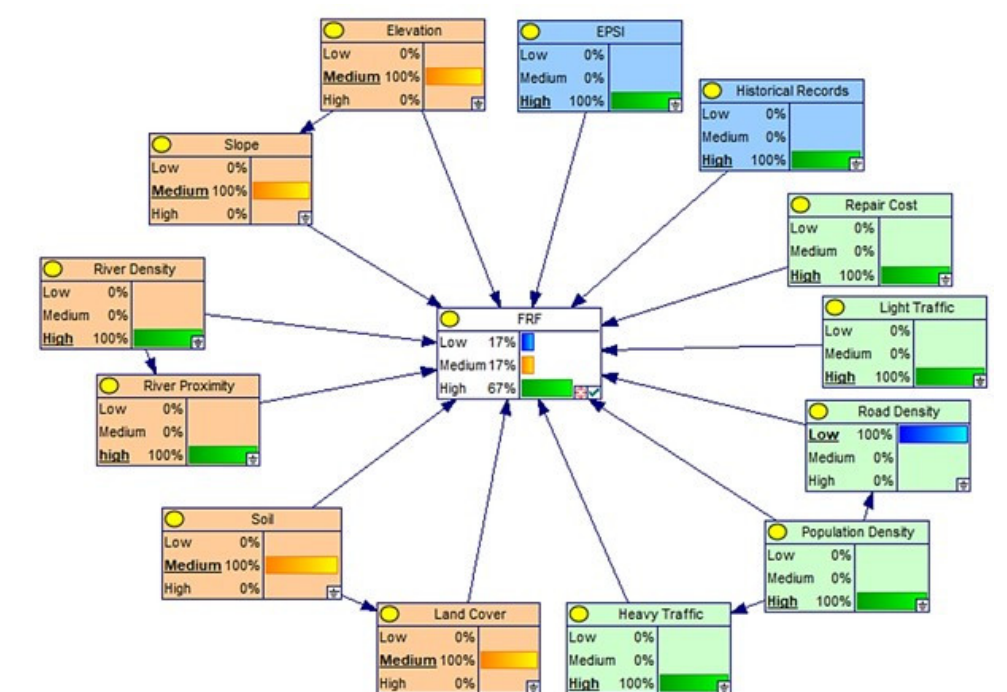
Figure 8. BN analysis FRF results of Vala da Azambuja road network